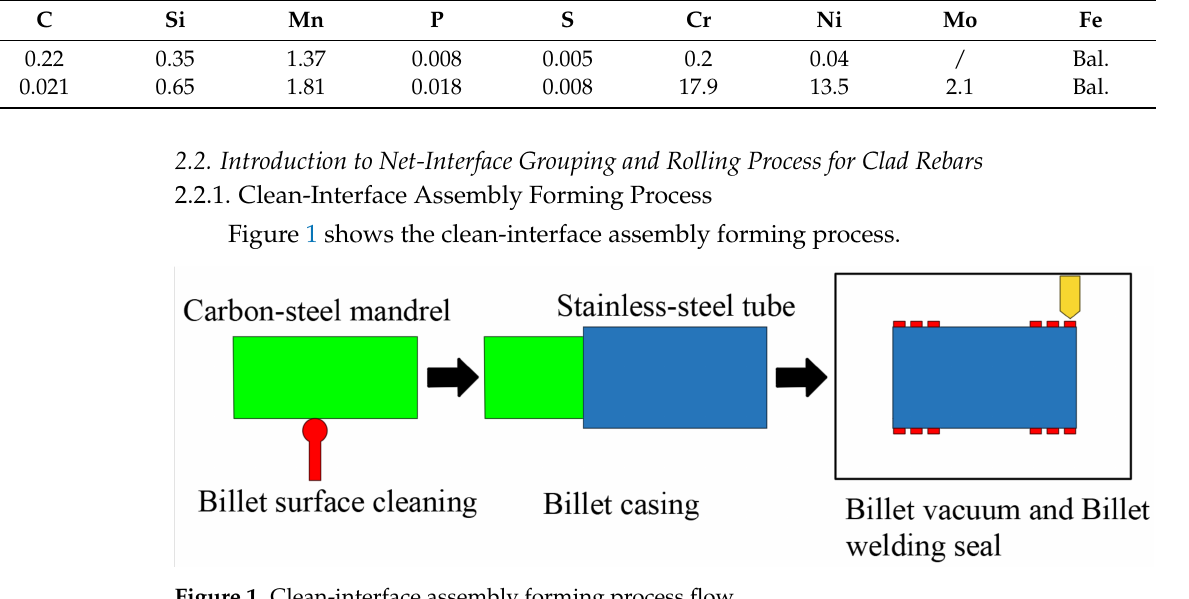
Figure 1. Clean-interface assembly forming process flow.